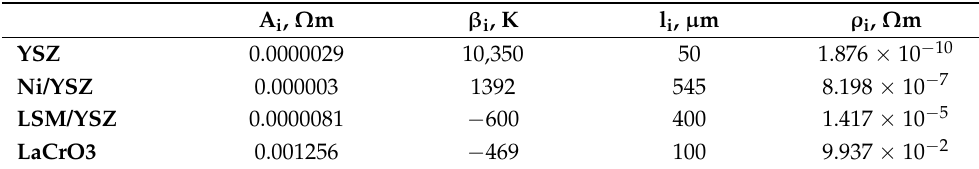
Table 6. Constants for the ohmic resistances calculation